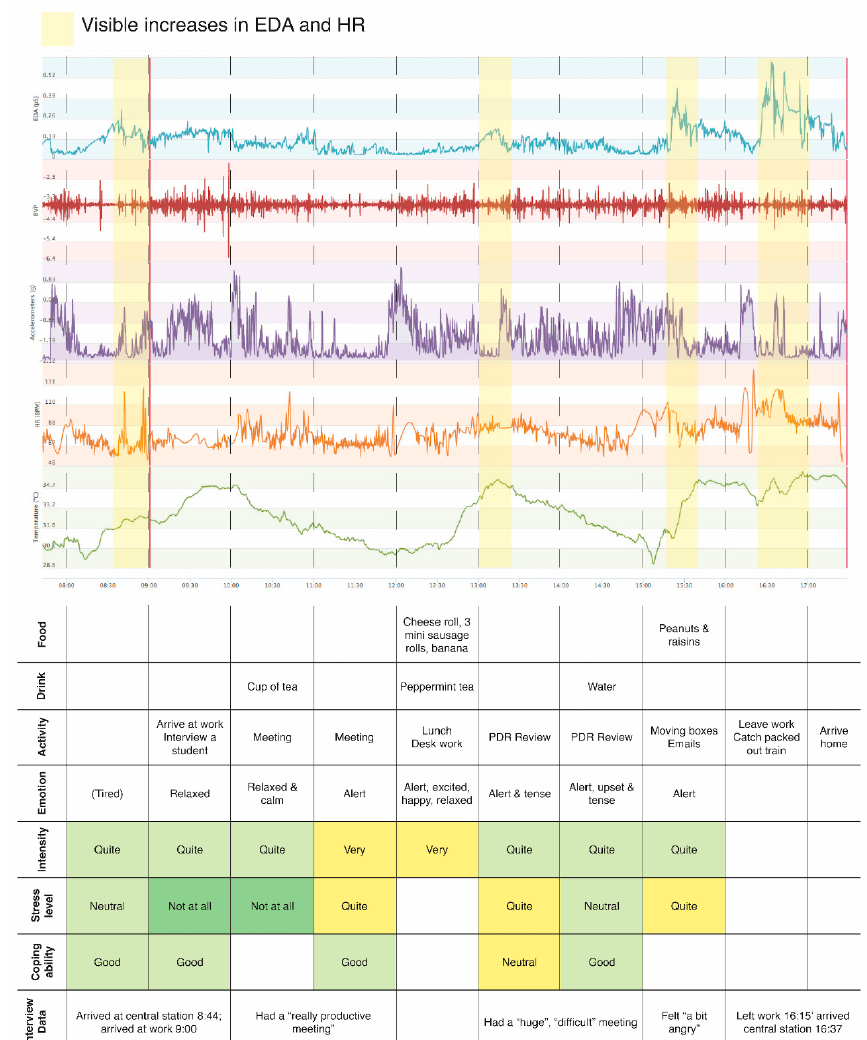
Figure 1. Example of biosensing and diary data visualization—feedback sheet for participants.